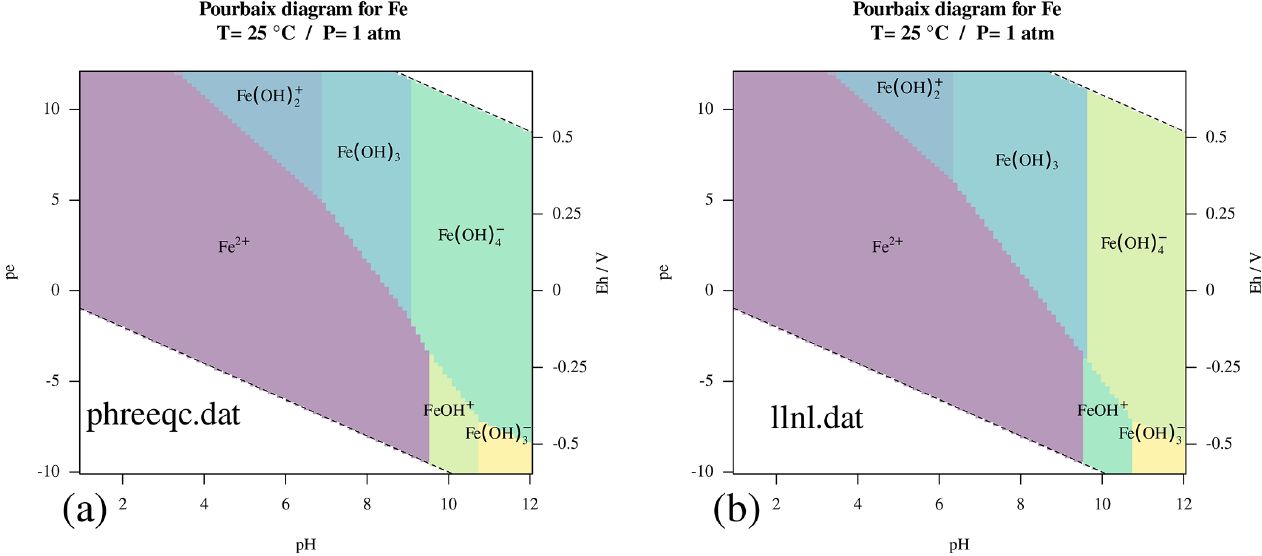
Figure 3. Pourbaix diagrams of aqueous iron speciation at 25 ◦ C and p = 01:00atm using two different thermodynamic databases: (a) phreeqc.dat and (b)